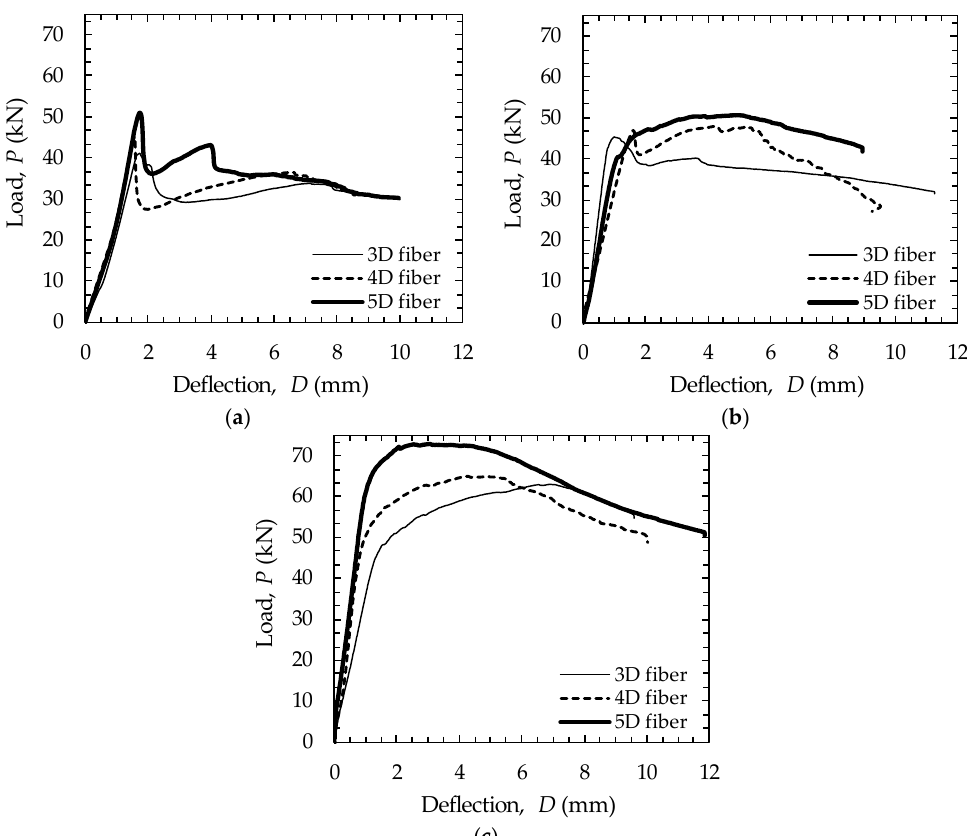
Figure 7. Summary of flexural load versus mid-span deflection curves: ( a ) v f of 0.37%, ( b ) v f of 0.60%, and ( c ) v f of 1.00%.